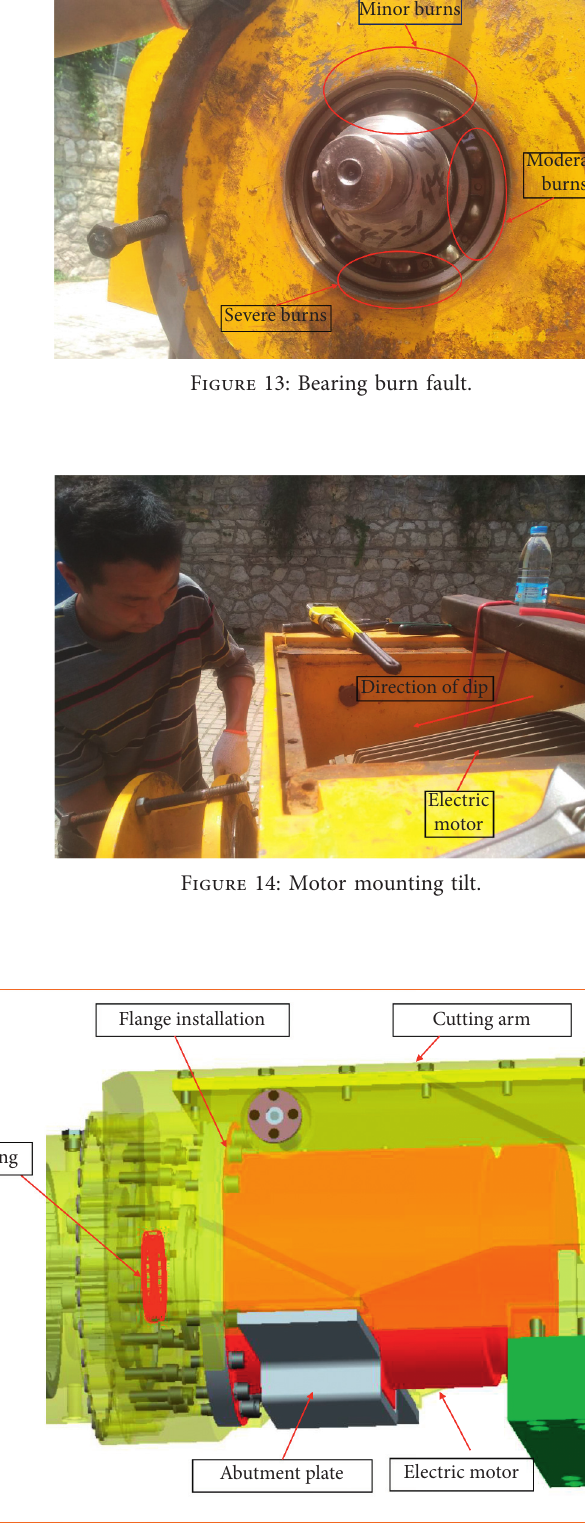
Figure 15: Hybrid installation scheme.